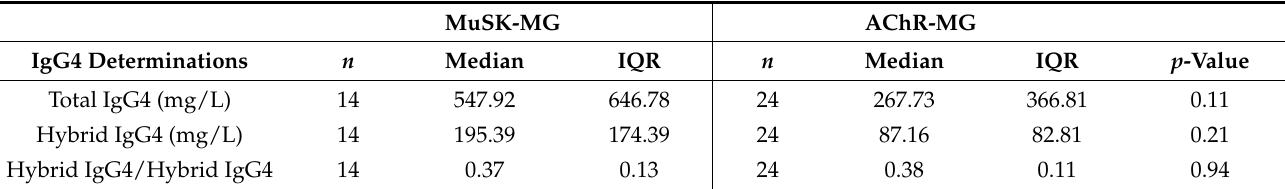
Figure 2. Box-plot analysis of Total IgG4, hybrid IgG4, and Hybrid/Total IgG4 ratio in 14 MuSK and 24 AChR-MG sera. The result of a Wilcoxon unpaired two-sample test is superimposed to each plot.